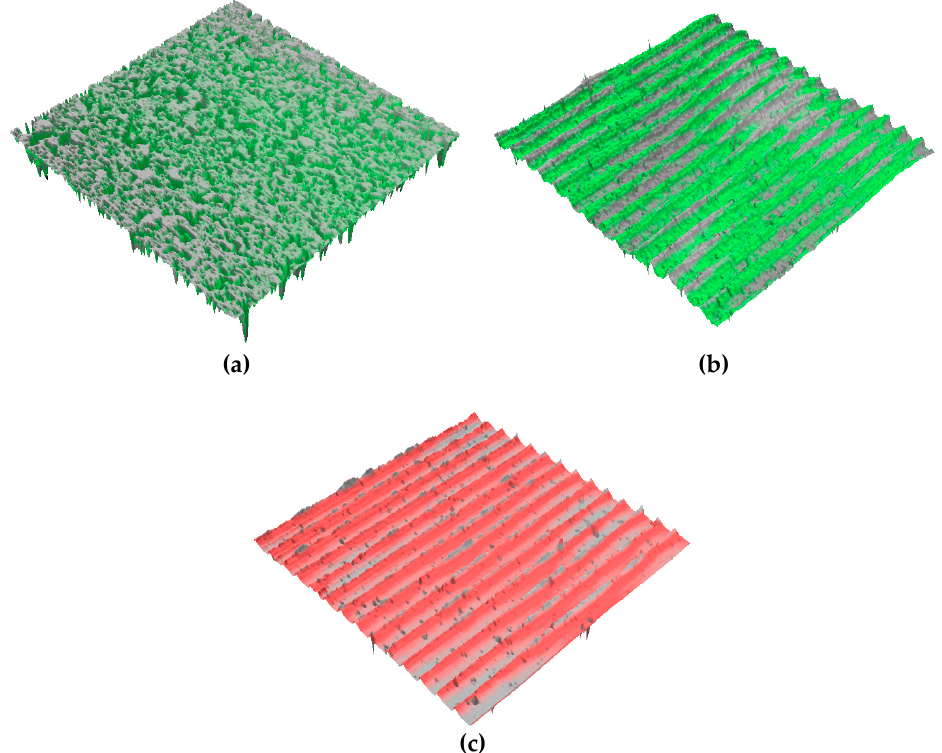
Figure 4. 3D images of the as-PM ( a ), UNSM-25 ( b ) and UNSM-300 ( c ) samples showing surface morphology (scan area: 2.0 mm × 2.0 mm).